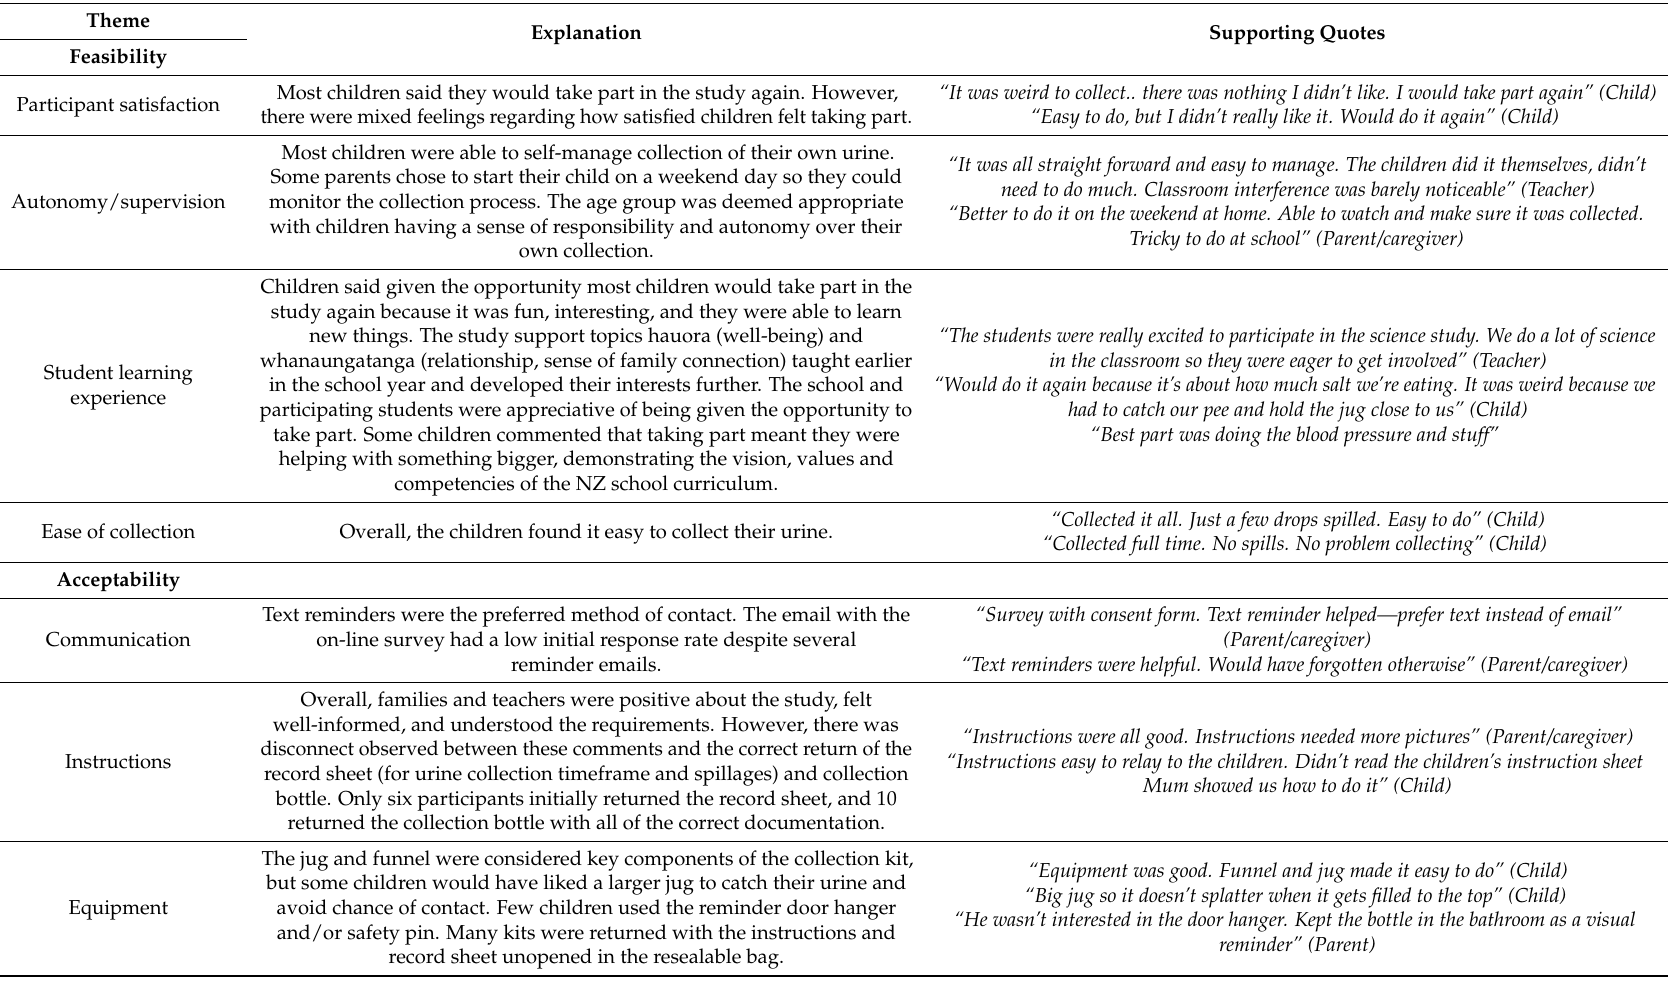
Table 3. Themes elicited from interviews with parents/caregivers ( n = 27) and teachers ( n = 6) on the feasibility and acceptability of 24-h urine